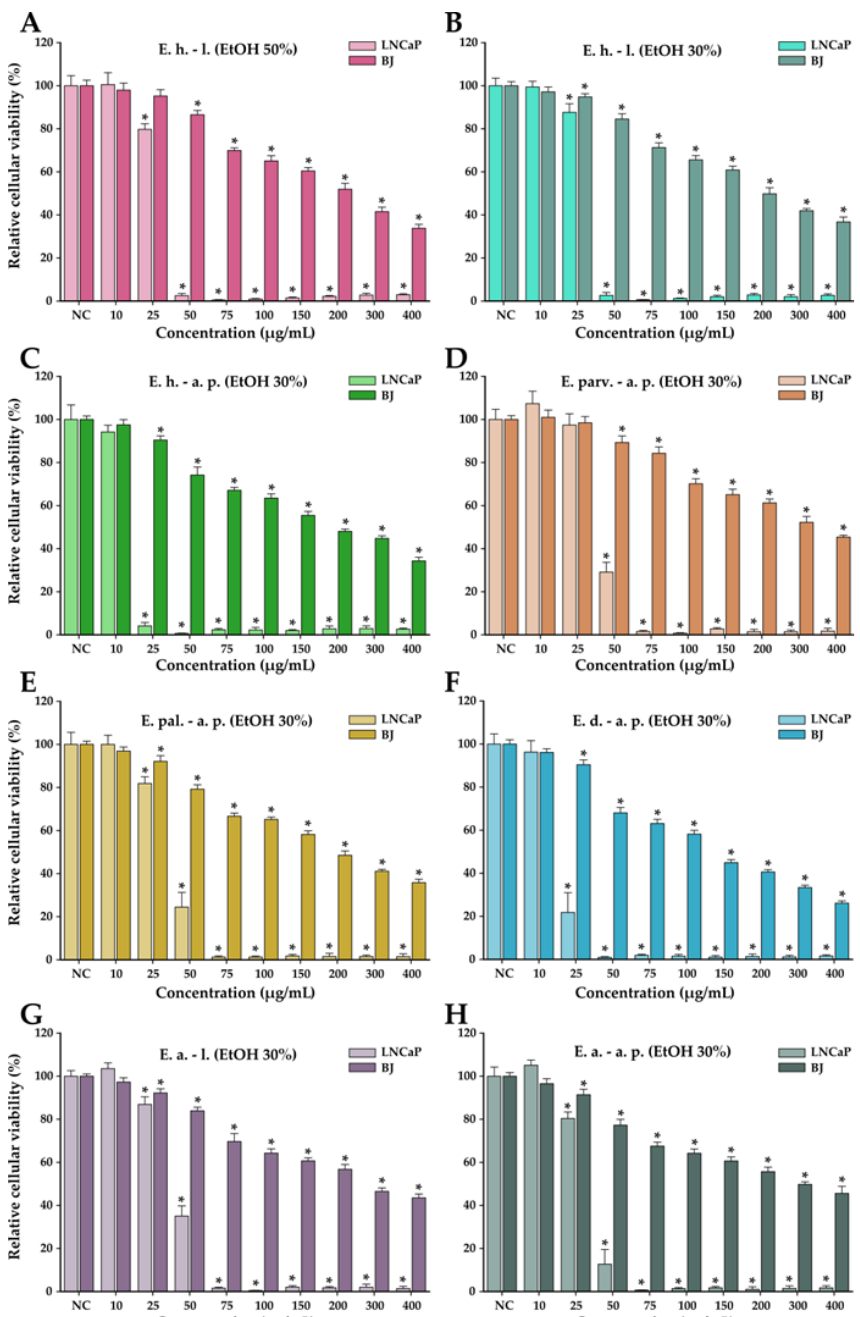
Figure 4. Cytotoxicity of E. hirsutum leaves EtOH 50% (A - E. h. – l.), E. hirsutum leaves EtOH 30% (B – E. h. – l.), E. hirsutum aerial parts EtOH 30% (C – E. h. – a.p.), E. parviflorum aerial parts EtOH 30% (D – E. parv. – a. p.), E. palustre aerial parts EtOH30% (E – E. pal. – a. p.), E. dodonaei aerial parts EtOH 30% (F – E. d. – a. p.), E. angustifolium leaves EtOH 30% (G – E. a. – l.), and E. angustifolium aerial parts EtOH 30% (H – E. a. – a. p.) evaluated using Alamar Blue assay on the LNCaP prostate carcinoma cell line and normal BJ human foreskin fibroblasts after a 24 h exposure. The results are expressed as the means ± standard deviations of three biological replicates (each one including 6 technical replicates). The values were calculated as relative values compared to the negative control (NC) (100%). Asterisks (*) indicate statistically significant differences in comparison with negative control (ANOVA + post hoc Holm-Sidak test at p < 0.05 )